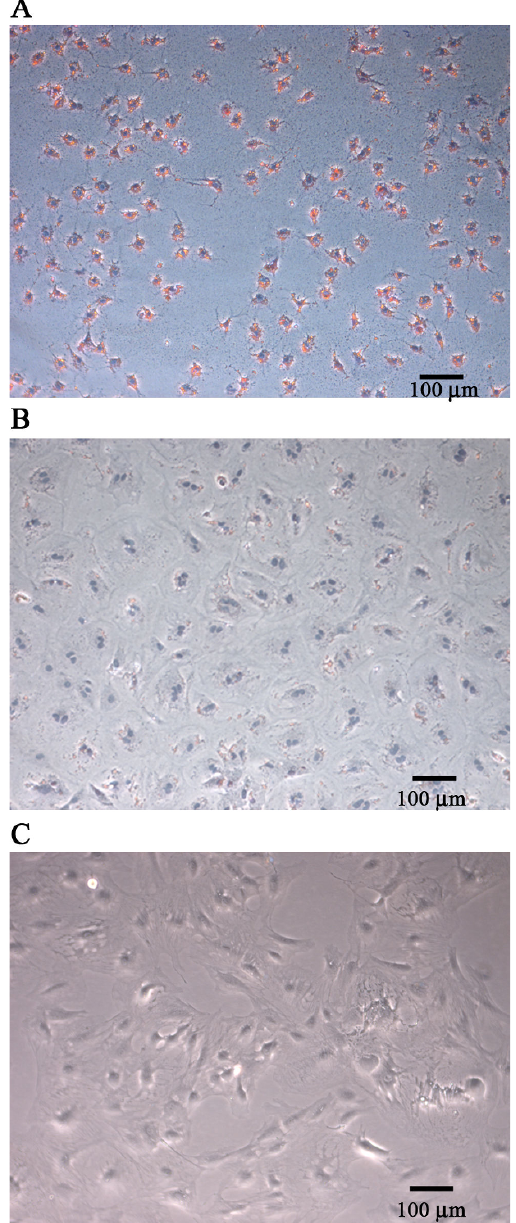
Figure 1 Light microscopic analysis of HSCs stained with Oil Red-O at different stages of transdifferentiation in primary culture . (A) Representative micrographs of HSCs cultured for 40 hours (A), 7 days (B) or sub-cultured for 5 days (C) showing changes in the morphology (from stellate shape to myofibroblast-like cells) and contents of lipid drop- lets. Note that HSCs cultured for 40 h contain variable amounts of lipid droplets. In sub-cultured (first passage) cells, there were no detectable lipid droplets as judged by Oil Red- O staining (data not shown). Original magnification: ×100. The micrographs shown are representative of cells obtained from at least two different